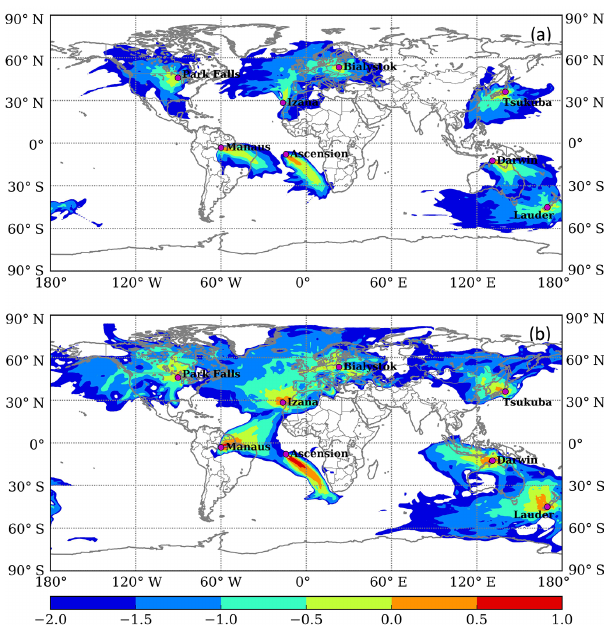
Figure 4. Footprints for different seasons for Ascension Island, Bi- ałystok, Darwin, Izaña, Manaus, Park Falls and Tsukuba, for (a) the summer (June, July and August) of 2010 and (b) the winter (De- cember, January and February) of 2010–2011.